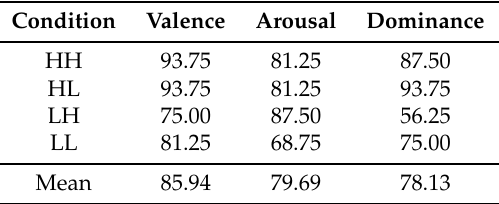
Table 3. Percentage of hits per condition.